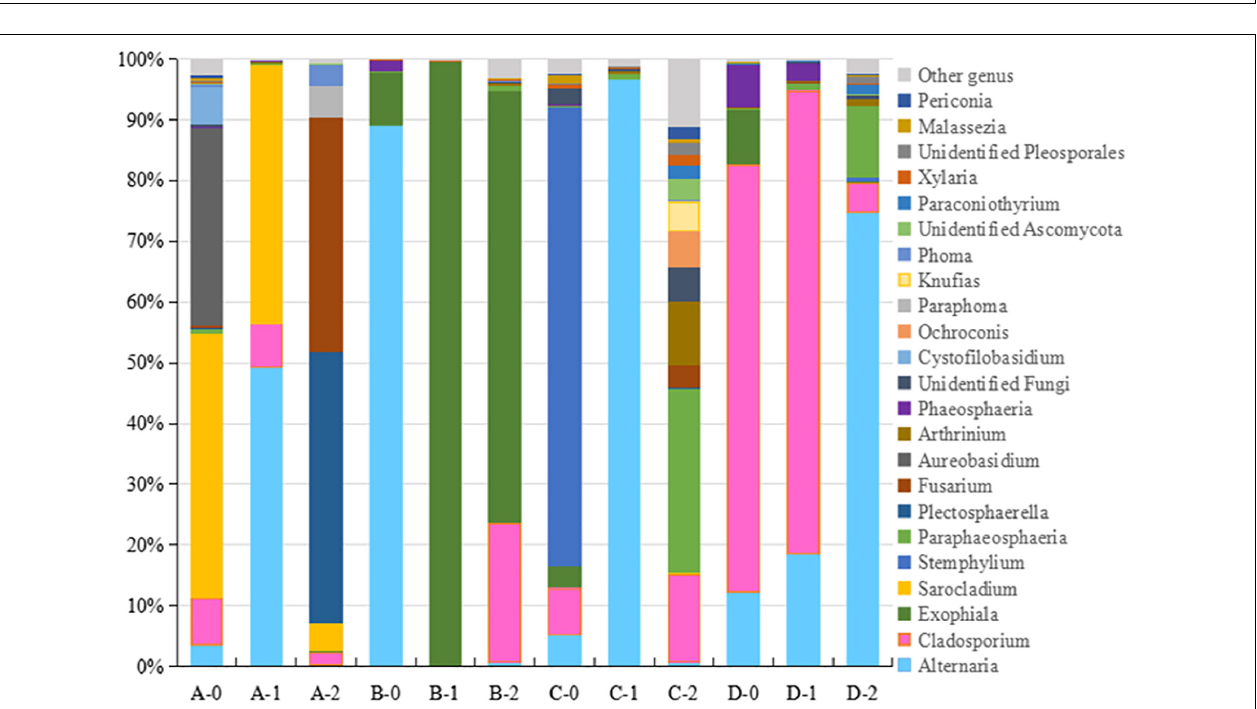
FIGURE 1 | The taxonomic diversity of fungi at class level. (A) : 12 depths at 4 locations (B) : 4 locations. A, B, C, D: location; 0: 0.05 m depth sediment (surface); 1: 1 m depth sediment; 2: 2 m depth sediment.